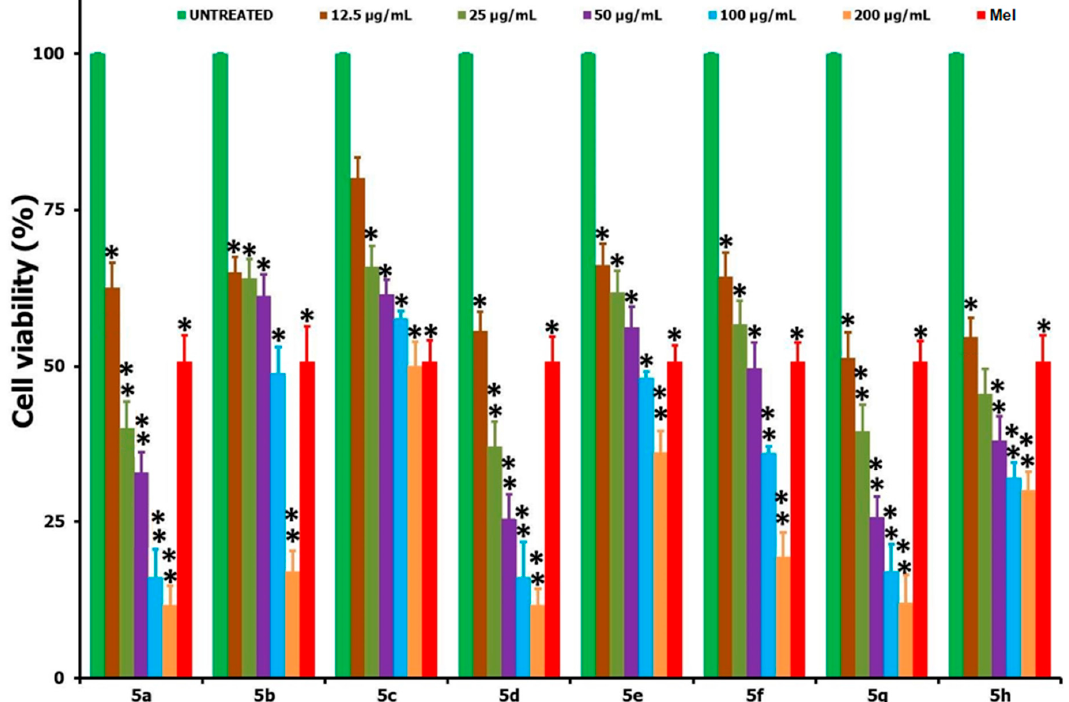
Figure 2. Comparison of the in vitro cell viability studies provided by the MTT assay when the HepG2 cancer cells were treated with compounds 5(a–h) at different concentrations in the range of 12.5–200 μ g/mL for a 24 h period. STD corresponds to Melphalan (Mel) (15 μ g/mL); * and ** correspond to the significant ( p < 0.05) and highly significant ( p < 0.01) values, respectively, against the untreated controlled measurements.